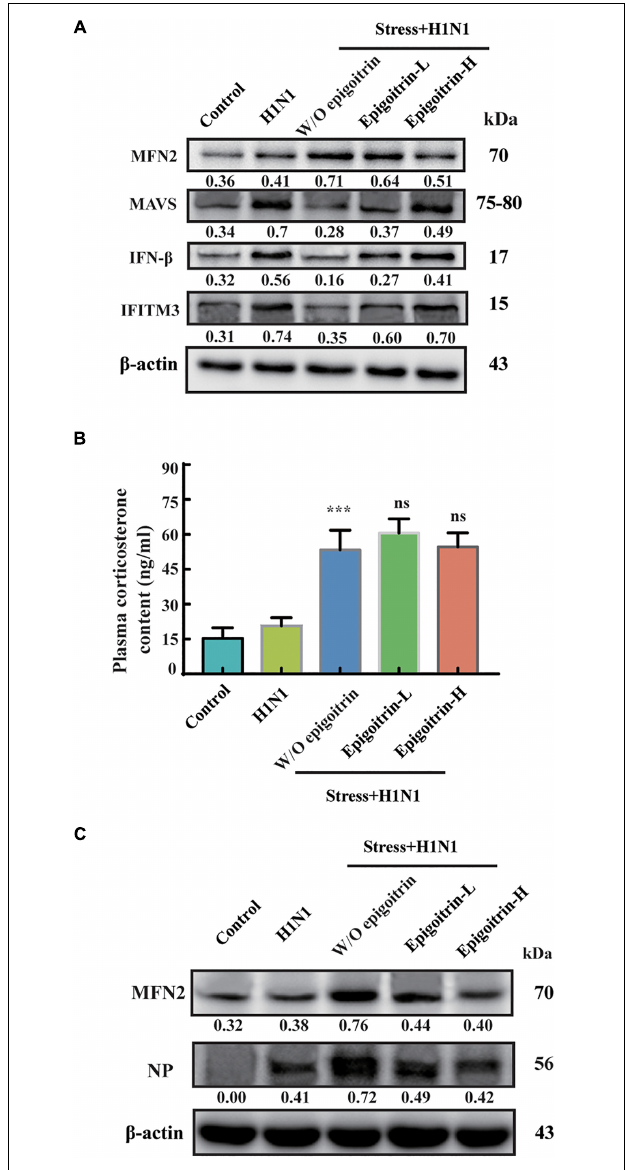
FIGURE 3 | Epigoitrin improved MAVS antiviral signaling after influenza infection in stressed mice. (A) Effects of epigoitrin on MFN2, MAVS, IFN- β , and IFITM3 protein expressions in the lung tissues. (B) Effects of epigoitrin on corticosterone level in the plasma. (C) Effects of epigoitrin on MFN2, NP protein expressions in the lung tissues. Actin was used as an internal control and the relative densities of the measured protein were quantified by image J software. ∗∗∗ P < 0.001 vs. H1N1 group; ns, no significance ( P ≥ 0.05) vs. Stress + H1N1